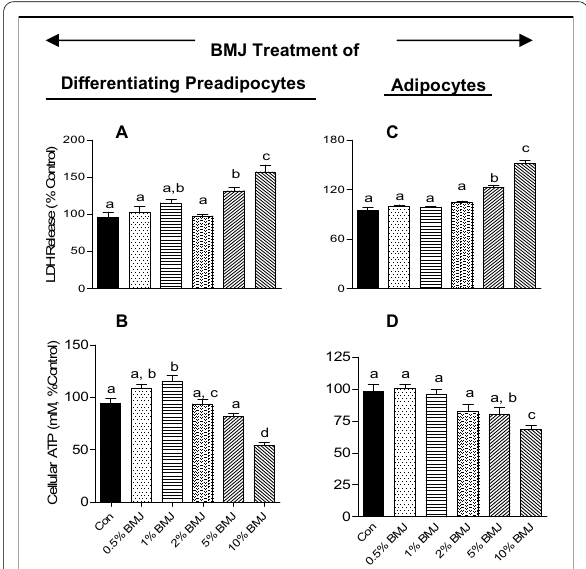
Figure 1 Cytotoxicity of bitter melon juice in human predaipo- cytes and adipocytes . Higher concentrations of BMJ, 5% and 10%, significantly increased LDH release and reduced total ATP levels in both, differentiating preadipocytes and adipocytes. Lower concentra- tions of BMJ, 0.5% to 2%, did not affect cell viability or cell proliferation in either differentiating preadipocytes or adipocytes. (A) LDH release and (B) cellular ATP levels in preadipocytes treated with BMJ during dif- ferentiation. Similarly, LDH release and cellular ATP levels in adipocytes treated with BMJ for 48 h, is depicted in Figures 1D and 1E, respectively. Values represent the mean ± SE (n = 6) of three independent experi- ments conducted in duplicate. a, b, c, d Mean values with common letters do not differ (p < 0.05).